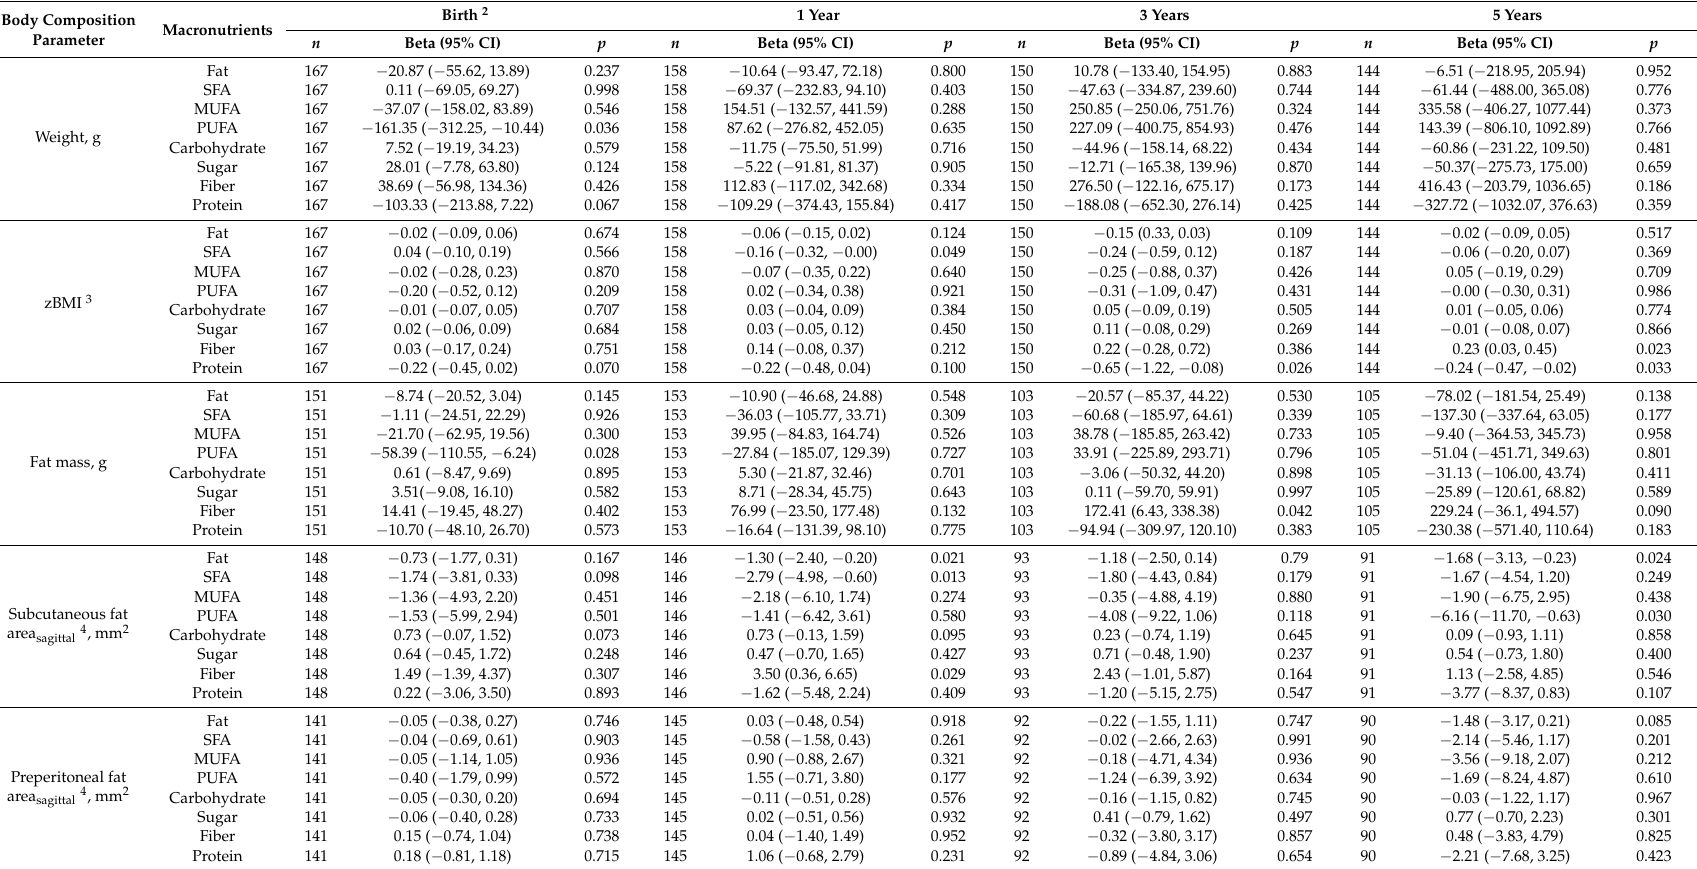
Table 5. Partition model from late gestation (32nd week of gestation) at birth, 1 year, 3 years, and 5 years 1